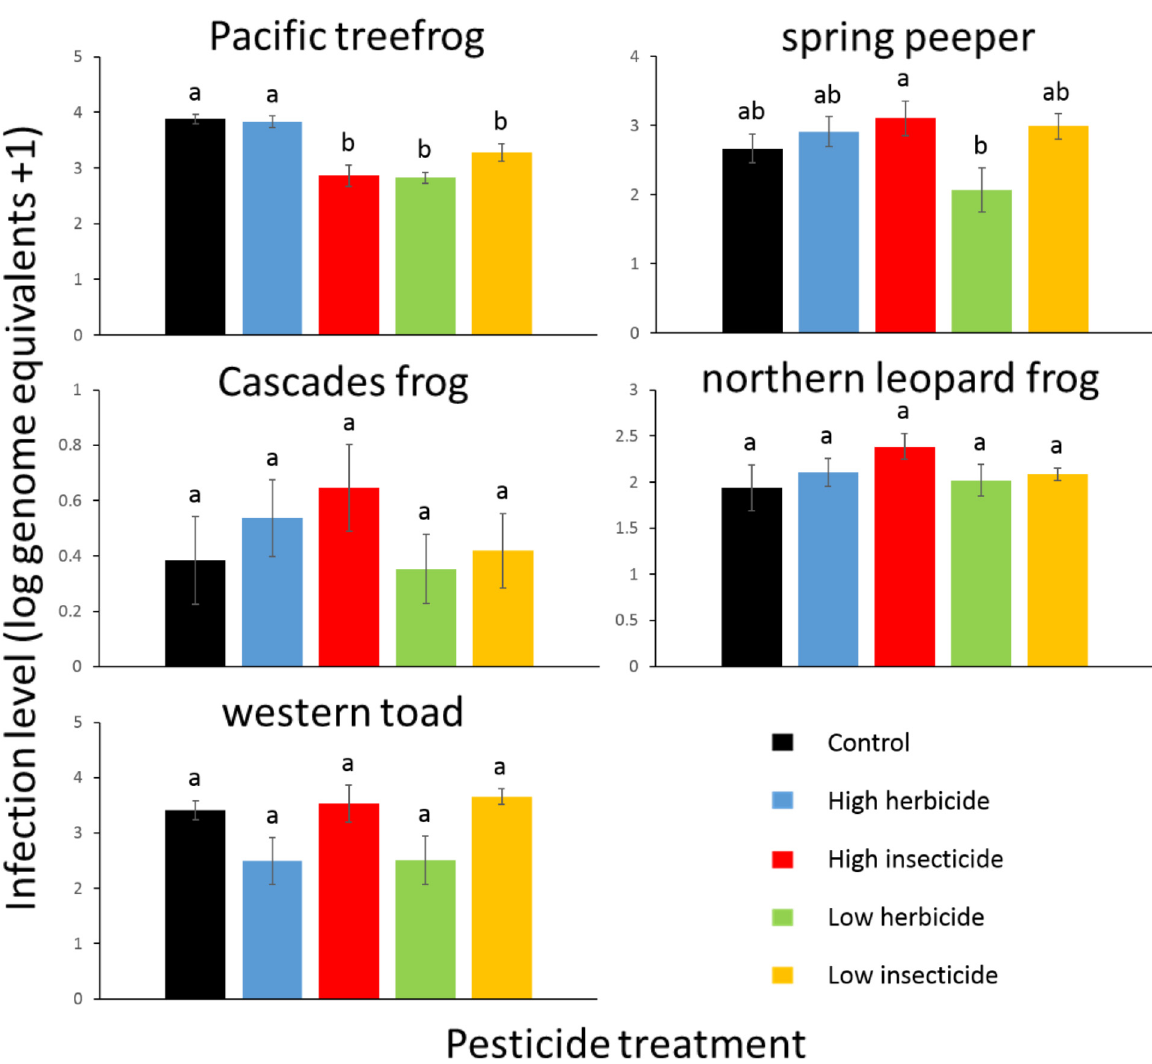
Fig 4. Infection level (log genome equivalents +1) for Bd-exposed amphibians exposed to pesticides after metamorphosis. Species are arranged phylogenetically (rows) and by geographic origin (columns). Values plotted are means ± 1SE.